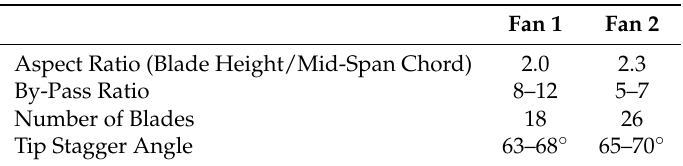
Table 1. Comparison of fan